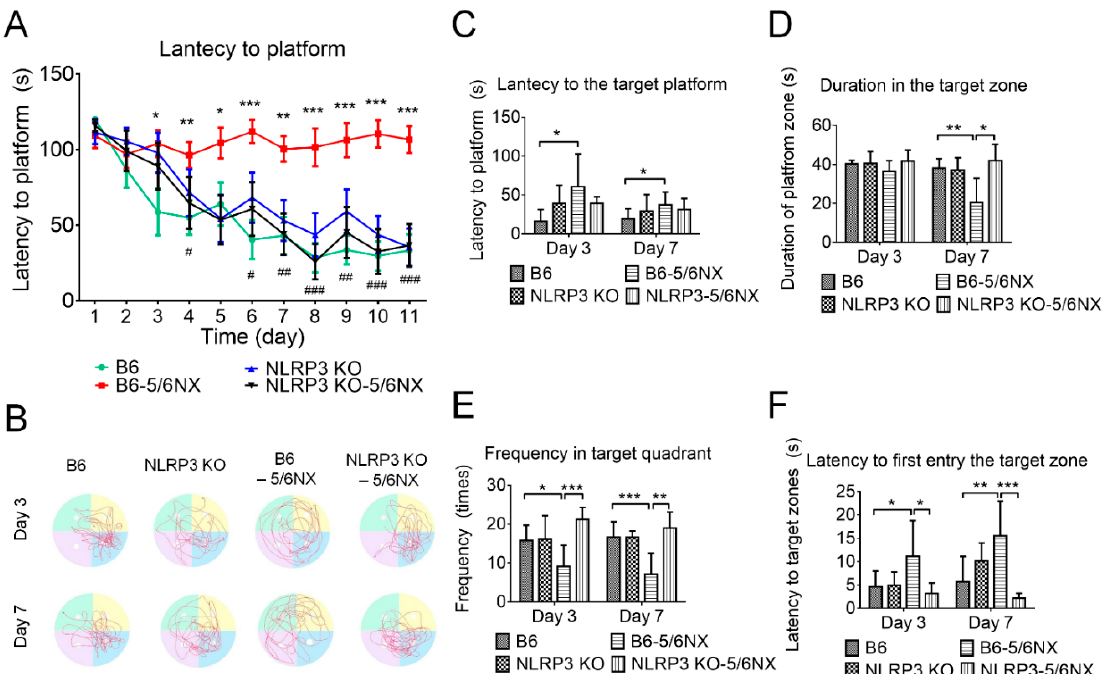
Figure 9. NLRP3-knockout (NLRP3 KO) mice that underwent 5/6 nephrectomy (5/6 NX) preserved better learning and memory ability than wild-type 5/6 NX-induced CKD mice. The results of the water maze training/learning period revealed that NLRP3 KO CKD mice showed similar latency in reaching the platform as control (B6) and NLRP3 KO mice, as well as a shorter latency than that in wild-type CKD mice (panel ( A )). We recorded the swimming track of the probe trial at day 3 and day 7 after the training period (panel ( B )) to determine the duration spent in the platform quadrant, latency in reaching the empty-platform position, latency in first reaching the platform quadrant, and frequency of entering the platform quadrant. Compared with CKD mice, NLRP3 KO CKD mice had a non-significantly shorter latency in reaching the platform position (panel ( C )), significantly longer duration in the platform quadrant on day 7 (panel ( D )), significantly higher frequency of entering the platform quadrant on both days 3 and 7 (panel ( E )), and significantly shorter latency in reaching the platform quadrant on both days 3 and 7 (panel ( F )). All the water maze results suggested that NLRP3 KO CKD mice showed resistance to CKD-induced cognitive impairment. (* 5/6 NX compared with B6 control, # NLRP3 KO+5/6NX compared with 5/6NX; * or # p ≤ 0.1, ** or ## p ≤ 0.01, *** or ### p ≤ 0.00; each group contained 8–12